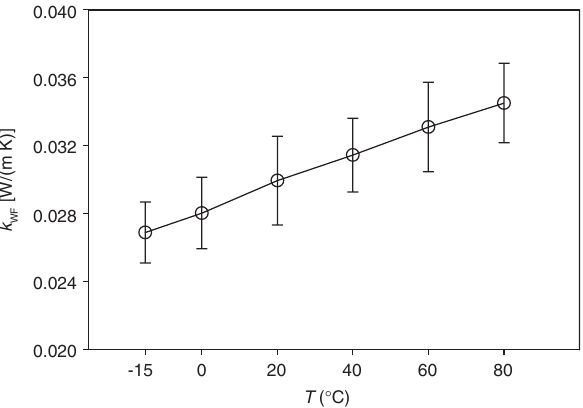
Figure 7 Estimated thermal conductivity of WM, the wood material in the WPC [the best-fit line, Eq. (9), is reported].